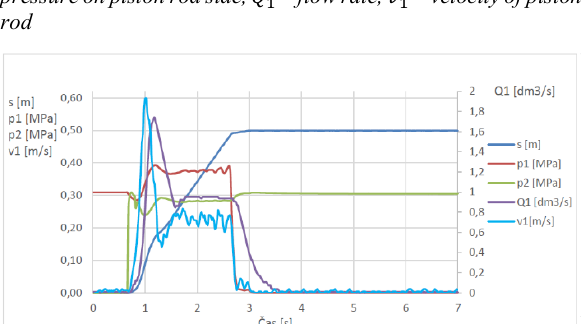
Fig. 7. Graph of measured data for retraction of piston rod, for working pressure 0.3 𝑀𝑃𝑎